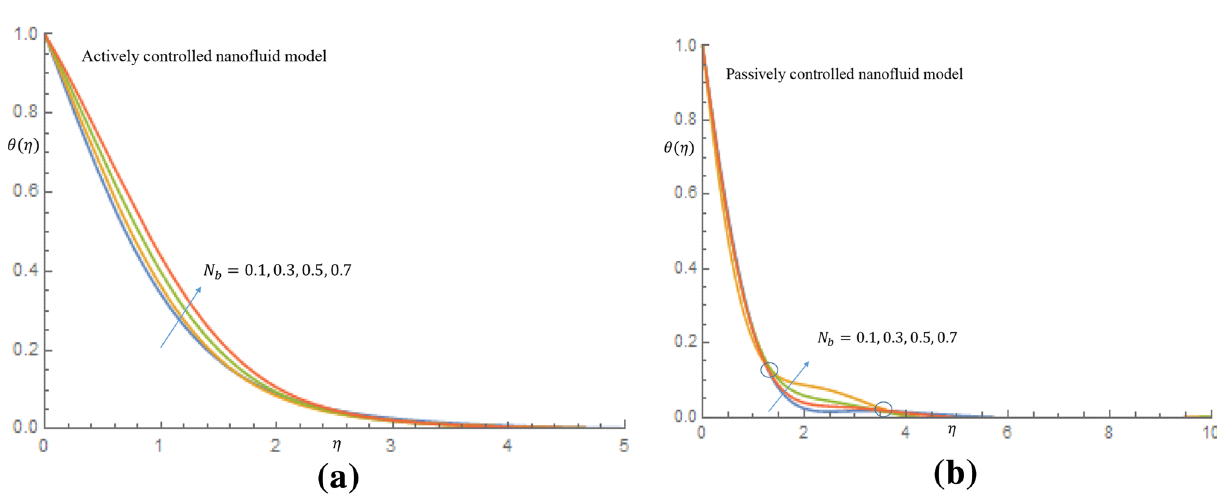
Figure 13. ( a ) Effect of N b on temperature profile when N t = 0.1 . ( b ) Effect of N b on temperature profile when N t = 0.1